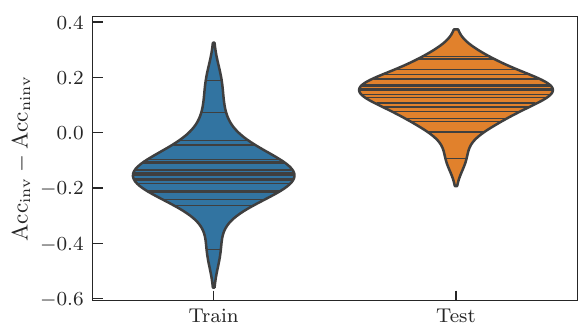
FIG. 8. Violin plot of the difference in achieved accuracies between the invariant and noninvariant models for 20 random parametrizations of the trainable blocks as detailed in the text. Positive values correspond to invariant models outperforming noninvariant ones. For every parametrization, ten random initial- izations are performed and then averaged. We see that the mean accuracy on the training data is more or less the same for both invariant and noninvariant models, but that the invariant models clearly outperform the noninvariant ones on the test data. The magnitude of the difference compares well to the absolute test accuracies of both models that lie between 0.48 and 0.80 (invari- ant) and 0.39 and 0.58 (noninvariant), significantly larger than the random guessing probability